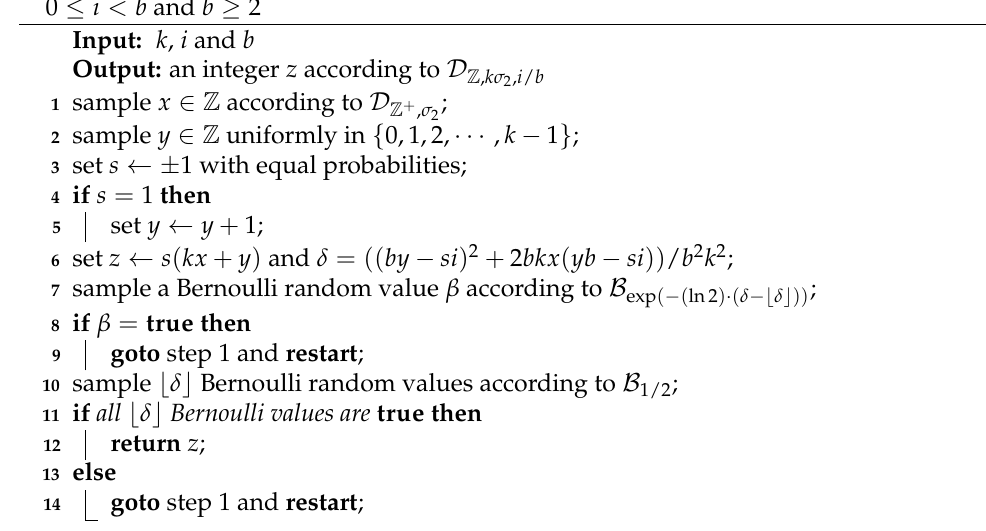
Algorithm 3: Sample from discrete Gaussian distribution D Z , k σ